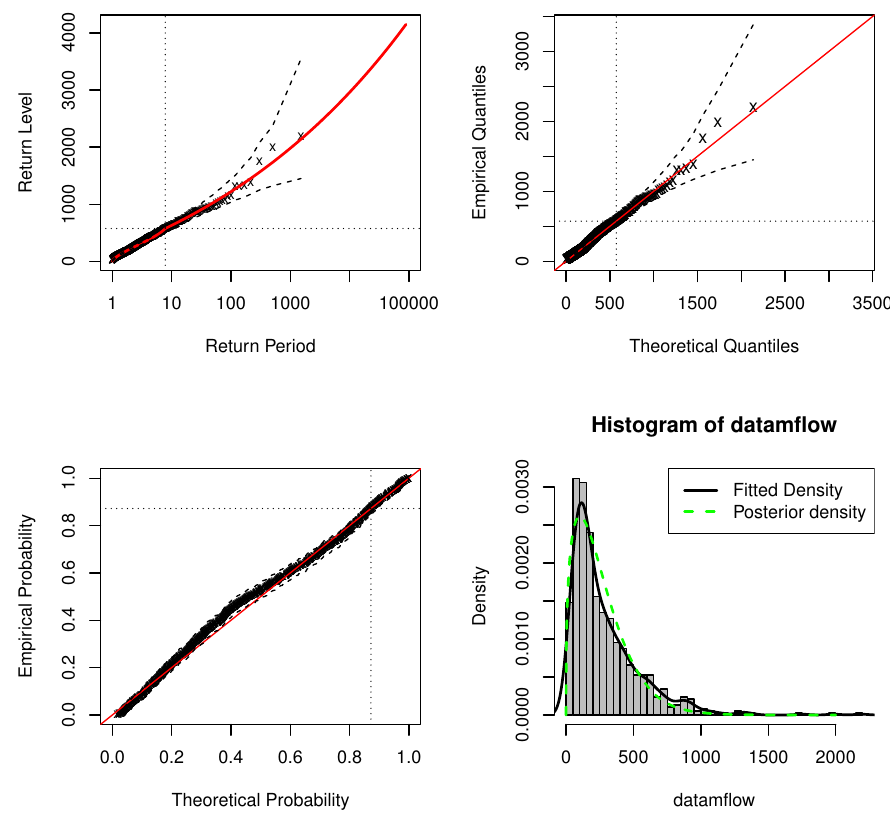
Figure 14. Standard model fit diagnostics for the DPMW-PPR model fitted to the Iowa River monthly flow. (The top left corner is the return level plot, the top right corner is the quantile plot, the bottom left corner is the probability plot, and the bottom right corner is the density